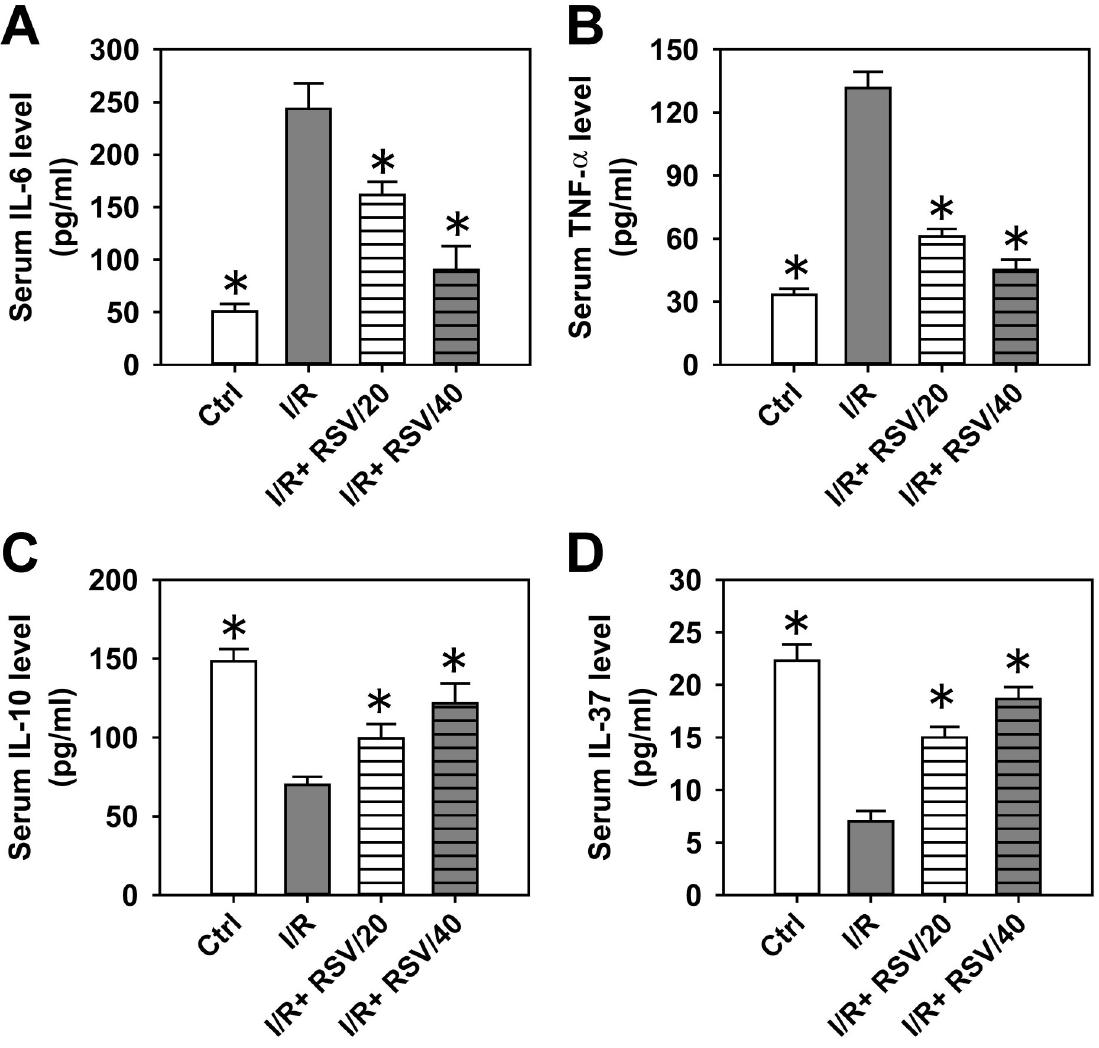
Fig 3. The effect of RSV on the inflammatory response induced by uterine I/R in rat serum. The concentrations of IL-6 ( A ), TNF- α ( B ), IL-10 ( C ) and IL-37 ( D ) in rat serum in control, I/R, I/R+RSV/20, and I/R+RSV/40 groups were examined by ELISA. Bars represent means ± SD, n = 3. � P < 0.05 vs . I/R